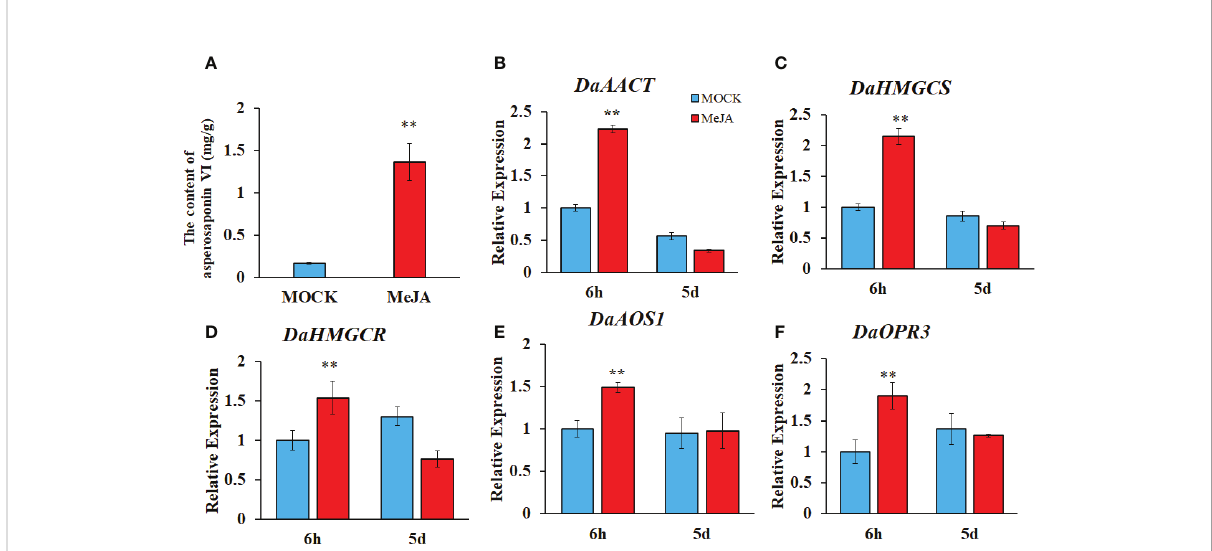
FIGURE 7 MeJA regulated the biosynthesis of asperosaponin VI in D. asperoides. (A) the content of asperosaponin VI in the roots following MeJA treatment for 5 d. (B – F) the expression of DaAACT , DaOPR3, DaAOS1, DaHMGCS, DaHMGCR in the roots following MeJA treatment for 6 h and 5d. All the values are the means ± SD; n = 3. Statistical analyses were performed using Student ’ s t test compared MOCK. **, P <